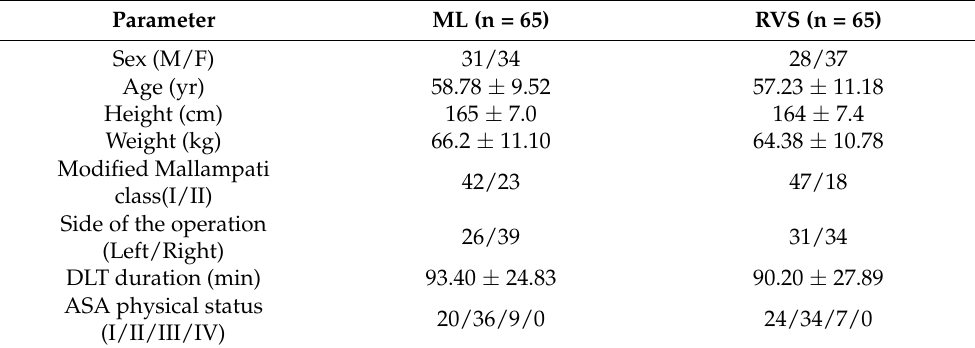
Table 1. Demographic and perioperative data.